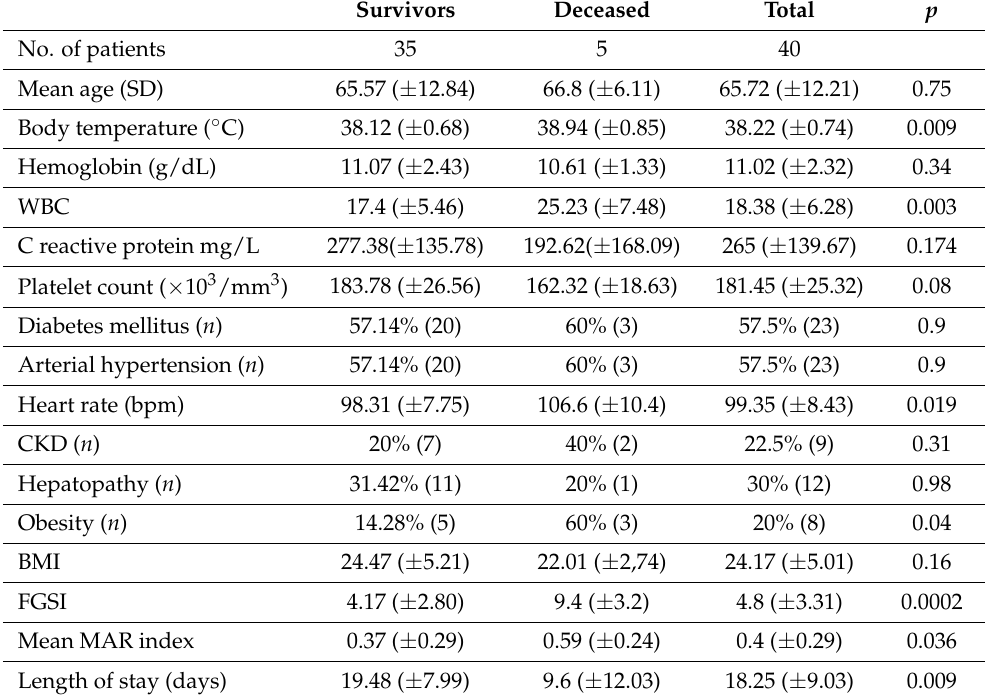
Table 1. Characteristics of included patients.